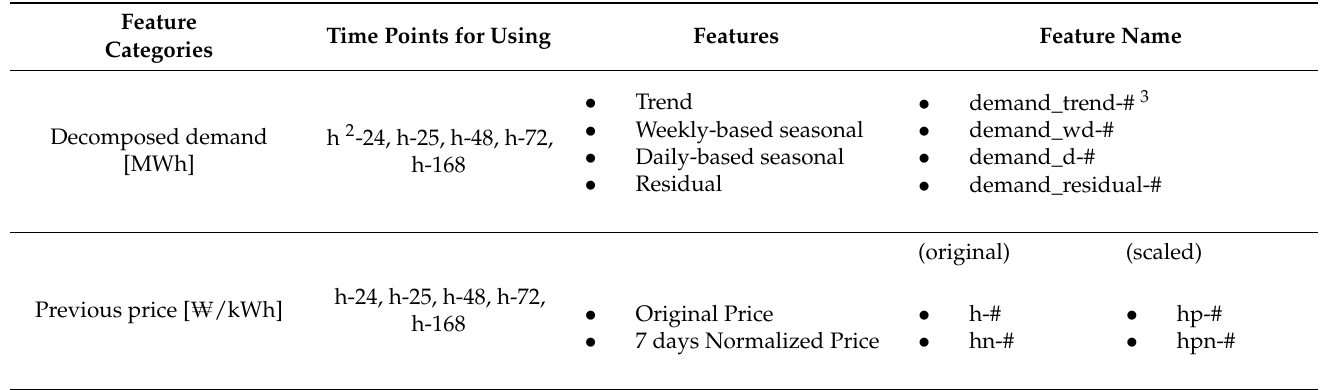
Table 1. Features and the label used in the case